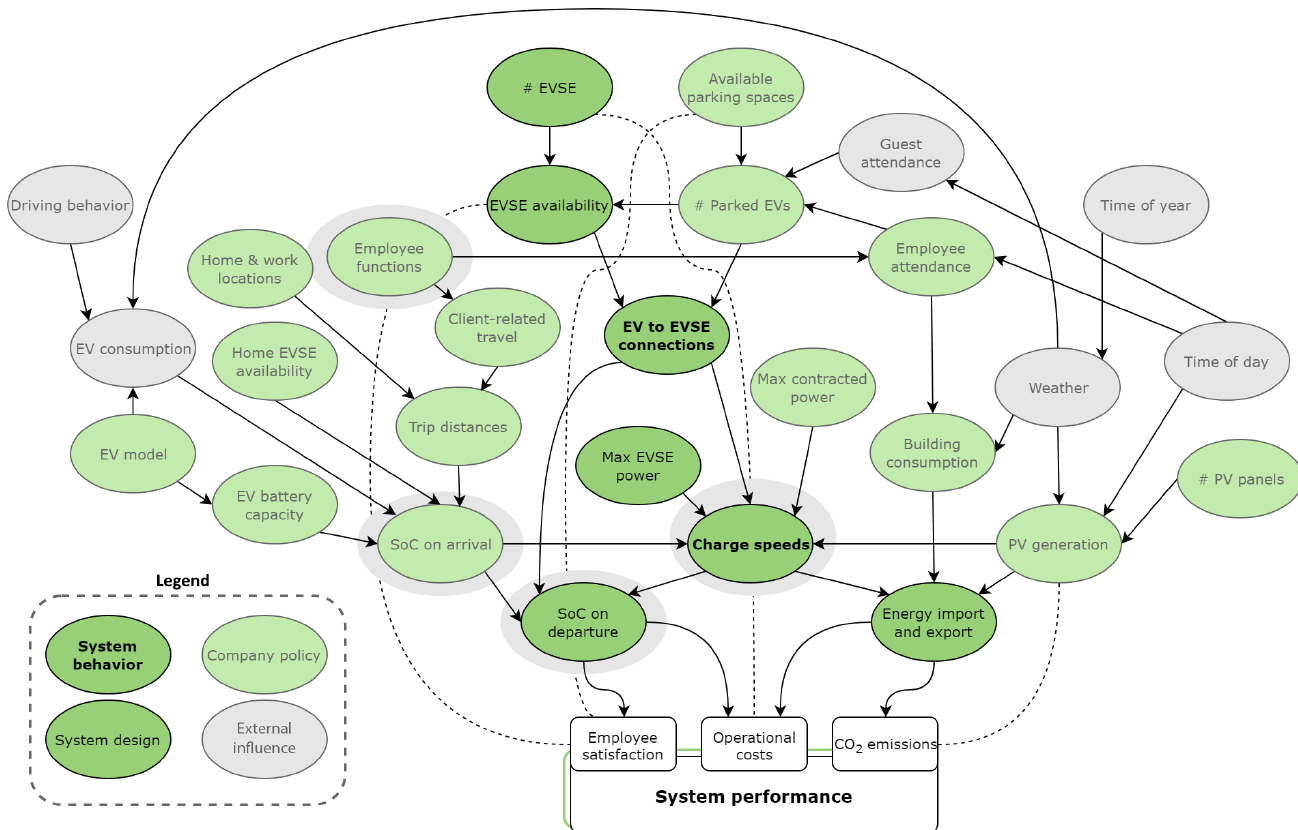
Figure 6. Logical Influence Diagram showing inputs and their relations. Solid lines represent main influences, dotted lines stand for additional